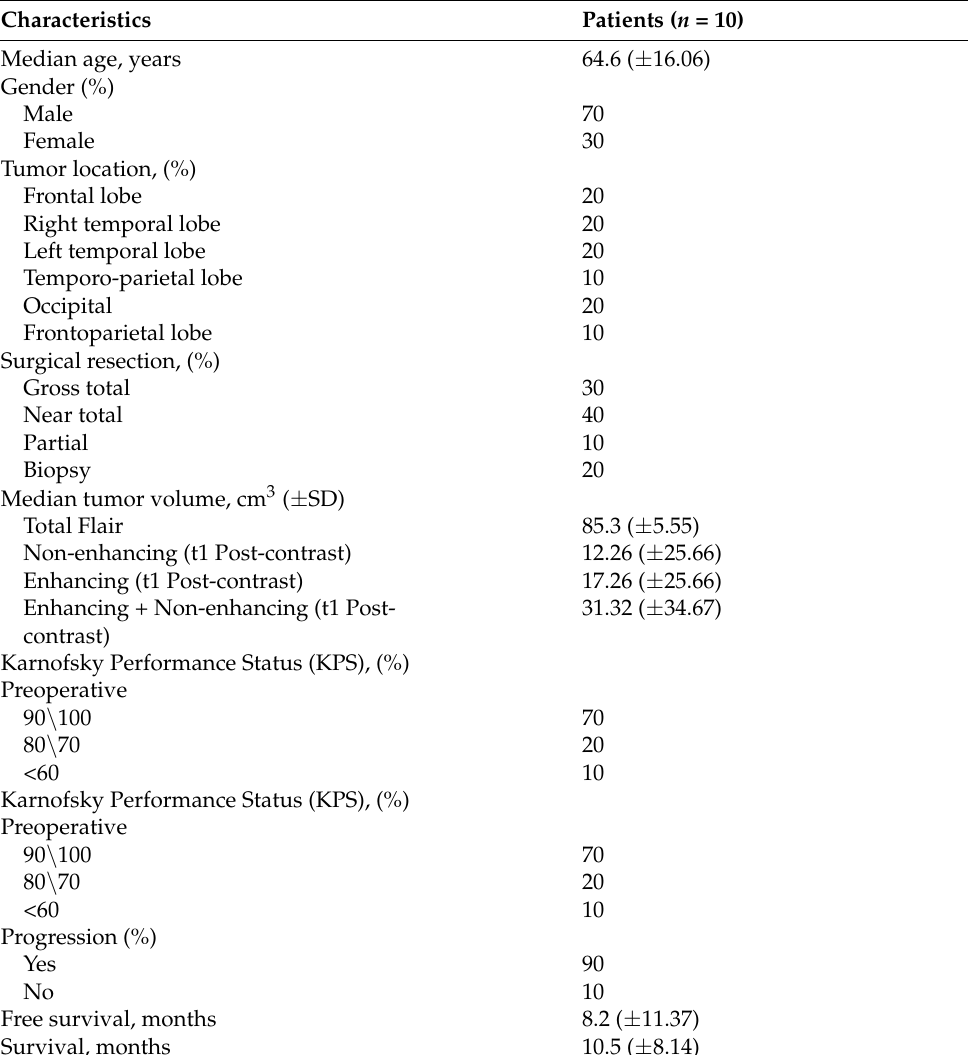
Table 3. Baseline characteristics of the adult glioma cohort of 10 patients screened for NGS